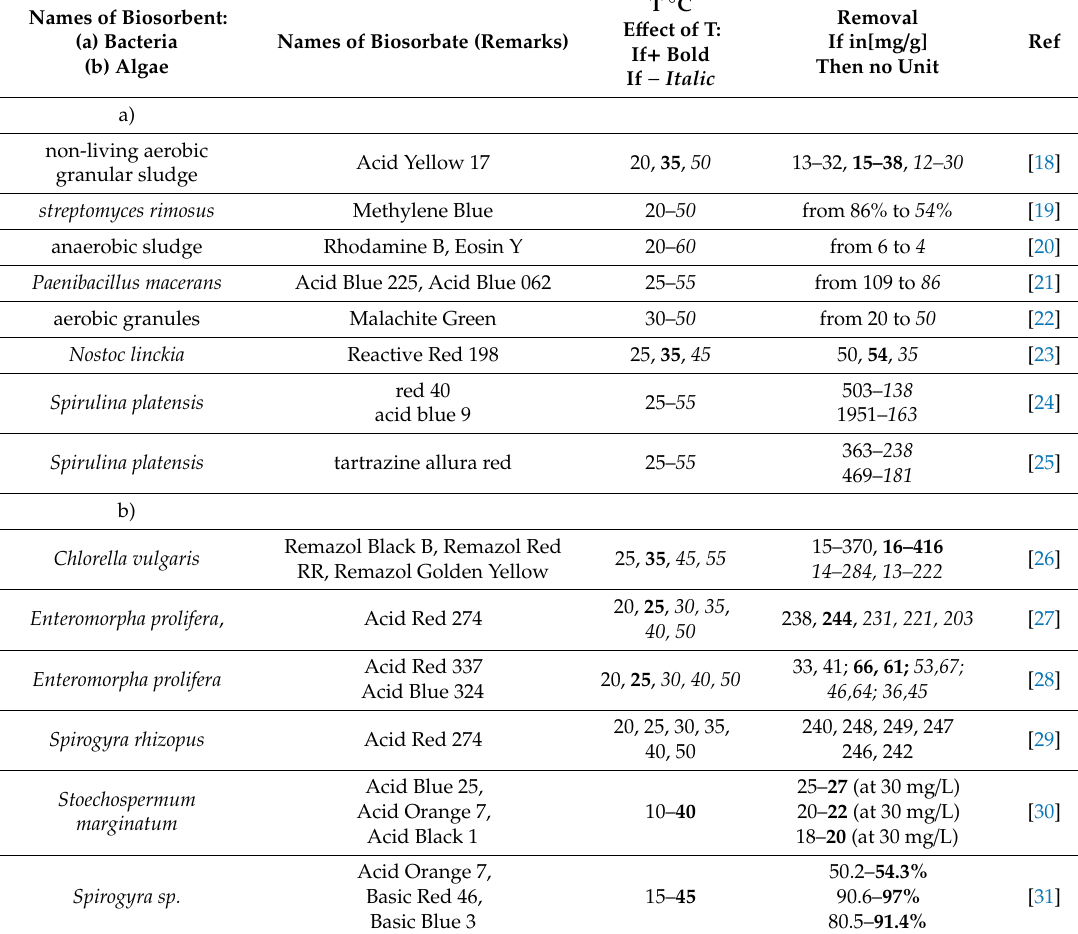
Table 2. Influence of temperature on the biosorption of dyes by bacteria and